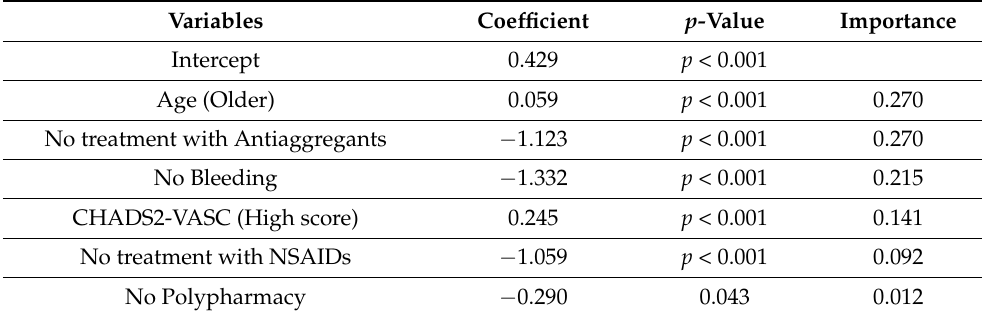
Table 4. Cross-tabulation of variables with HAS-BLED.